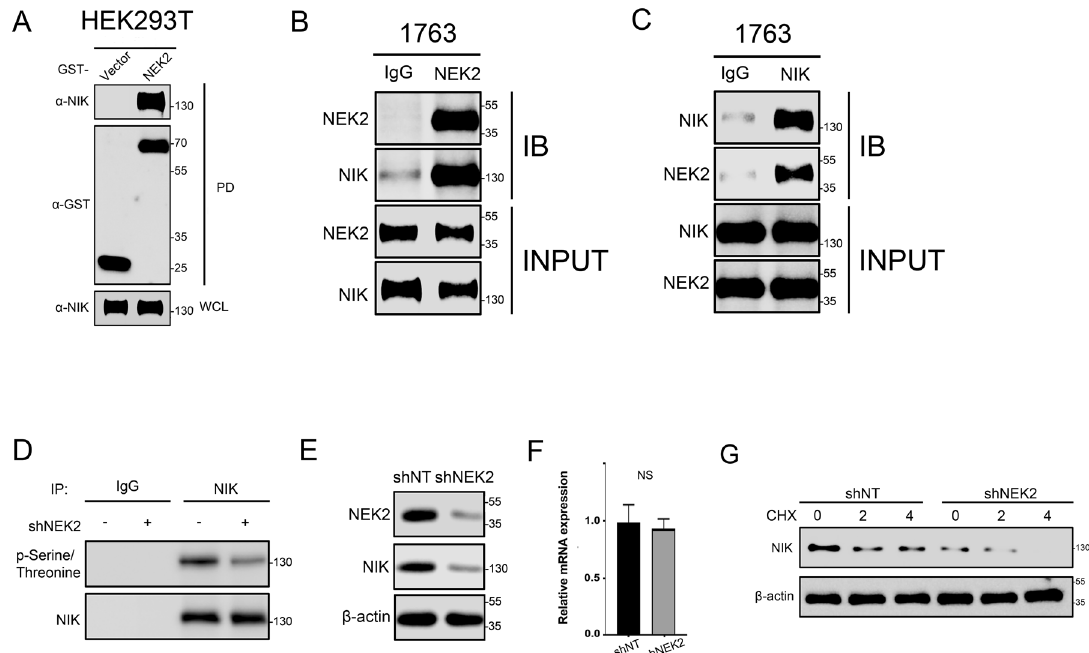
Fig. 6 NEK2 activated noncanonical NF- κ B signaling pathway by phosphorylating NIK. A GST pull-down assays were used to explore the interaction between NEK2 and NIK. B and C Immunoblotting (IB) for IP using a NEK2 antibody ( B ) or a NIK antibody ( C ). Nonspeci fi c antibody IgG was used as a negative control. D Western-blot assays were used to detect the phosphorylation levels of NEK2 knockdown GBM cells and control GBM cells. E Western-blot assays for measuring the protein levels of NIK in NEK2 knockdown GBM cells and control GBM cells. F qRT- PCR analysis was performed to detect the mRNA levels of NIK in NEK2 knockdown cells and control cells. G The effect of proteasome inhibitor MG132 on protein level of NIK in GBM cells pretreated with or without shNEK2 lentivirus. β -actin was used as an internal control. All data were presented as the mean ± SD of triplicate independent